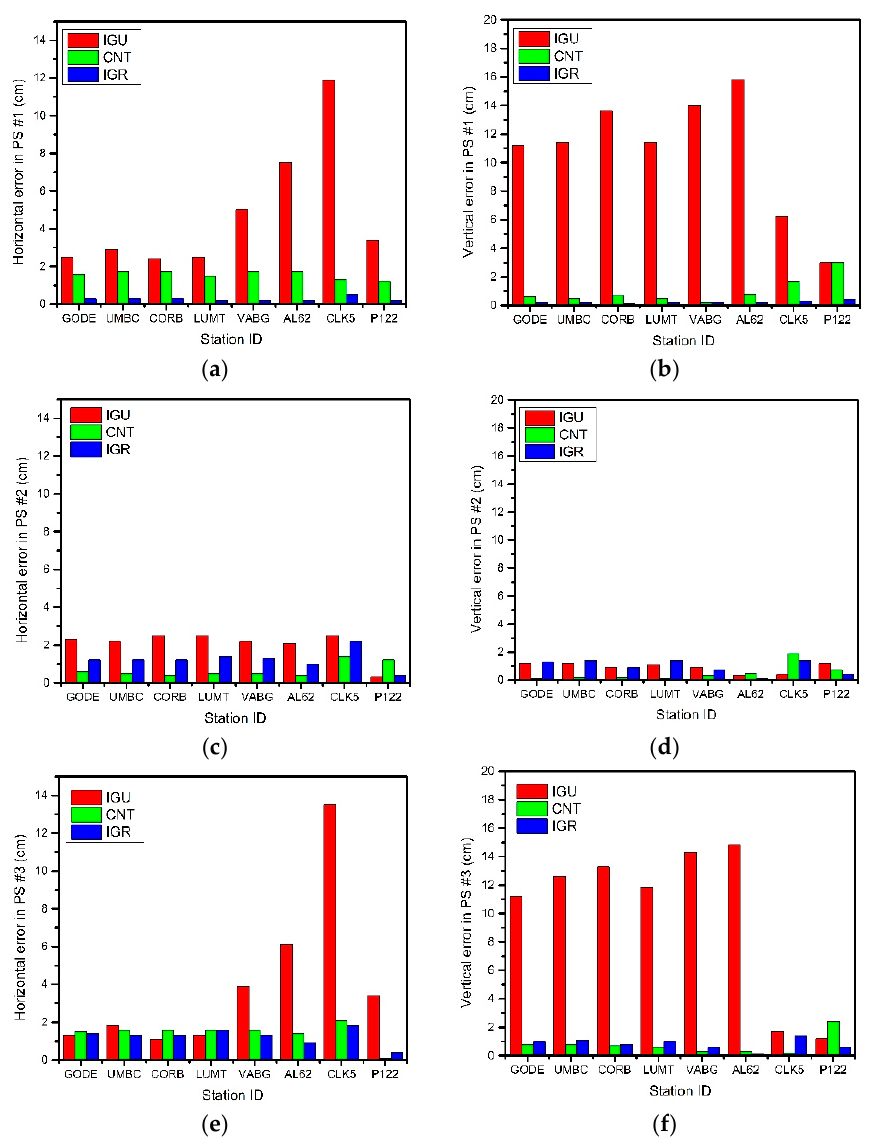
Figure 3. Horizontal ( a,c,e ) and vertical ( b,d,f ) point positioning errors of the PS #1 ( a,b ), #2 ( c,d ), and #3 ( e,f ) on DOY 279.